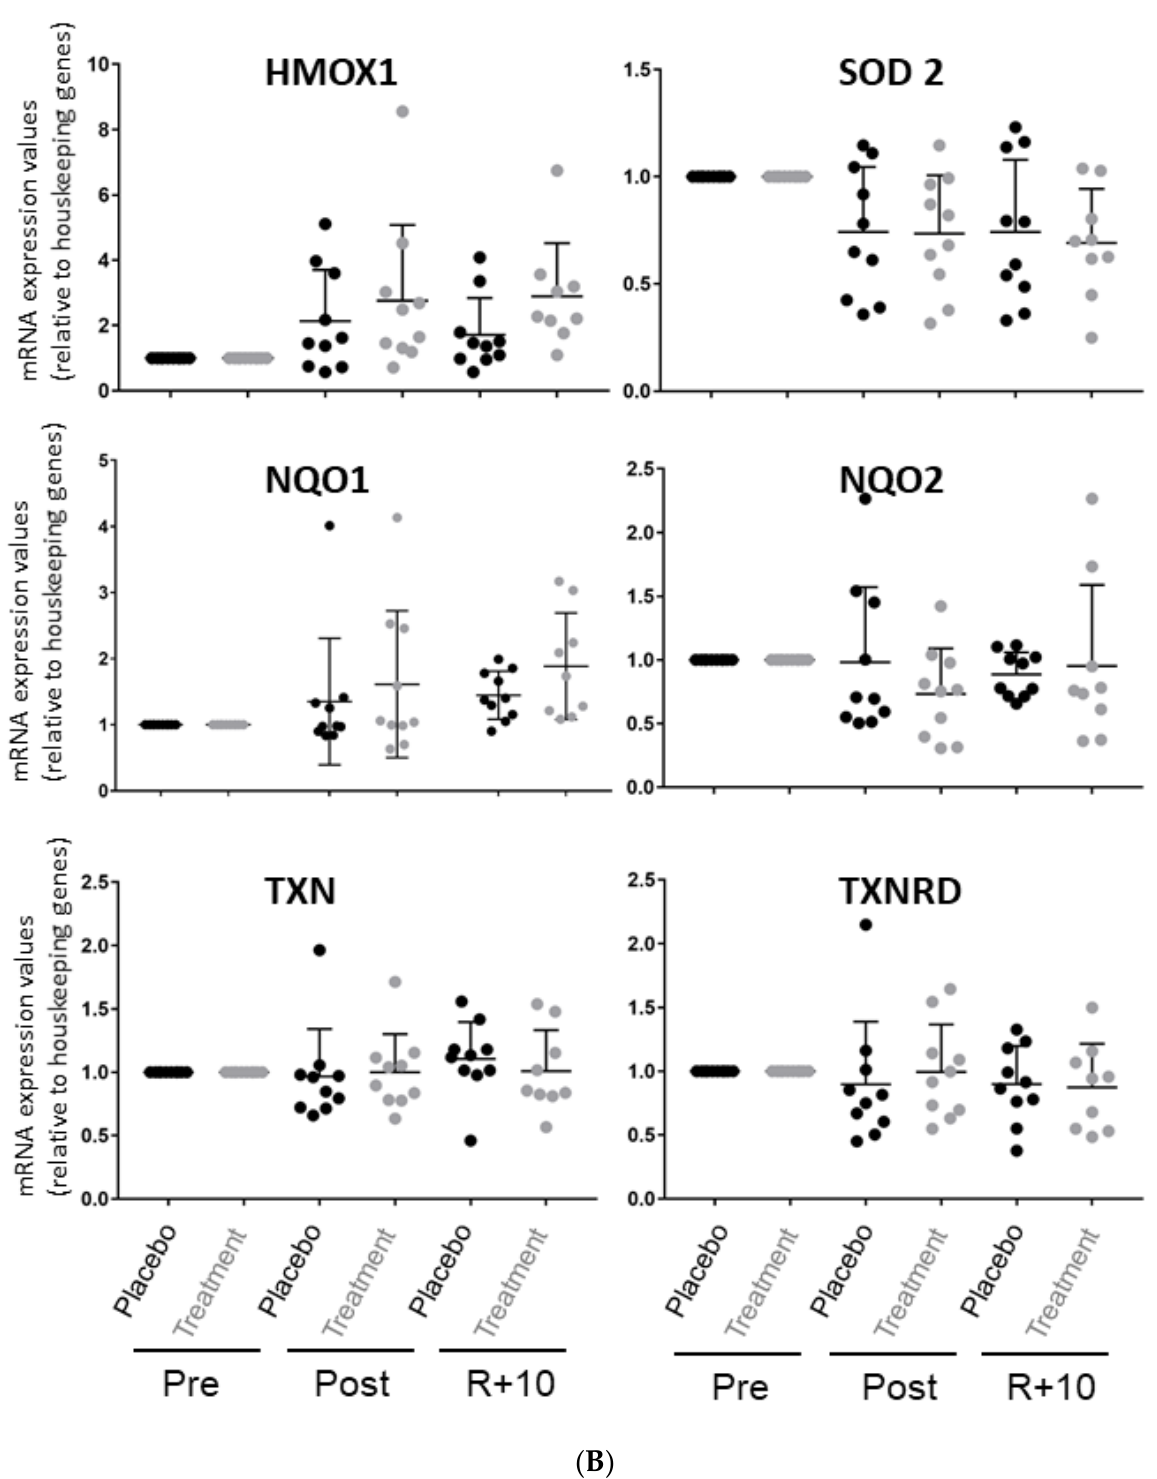
Figure 6. ( A , B ) Antioxidant responsive element (ARE) gene quantitative PCR (qPCR) analysis in VL muscle biopsies. ( A ) Scatter plots showing the relative mRNA expression levels of CAT, GCLC, GPX1, GSTK1, GSR, and GSNOR; ( B ) scatter plots showing the relative mRNA expression levels of HOMX1, SOD2, NQO1, NQO2, TXN, and TXNRD in VL muscle biopsies before (Pre), after (Post) bedrest (BR) and 10 days after ambulation or recovery (R + 10). Investigated ARE gene mRNA levels of each subject enrolled in the two BR campaigns ( n = 10 for each campaign) are shown (Significant difference, ANOVA and t -test, n = 10, p -value ≤ 0.05). The graph represents the mean ± SEM.